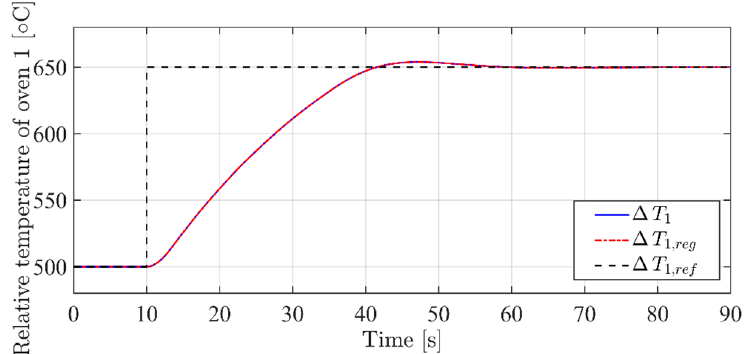
Figure 12. Performance comparison— 𝛥𝑇 (cid:2869)